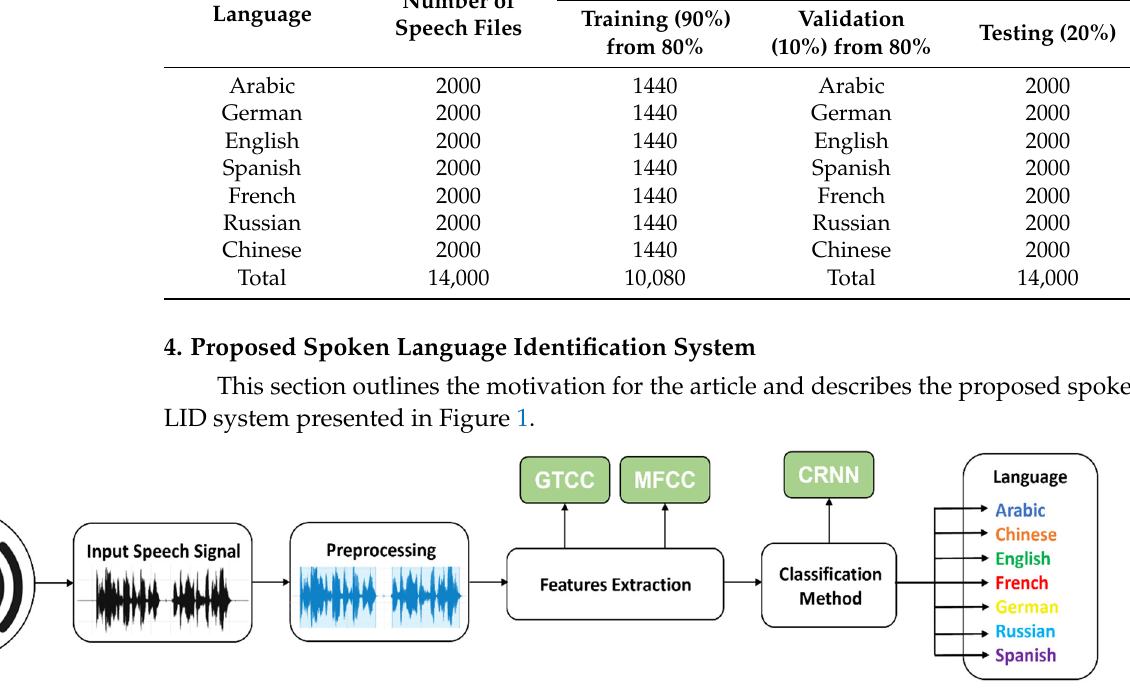
Table 3. Selected Mozilla corpus description.